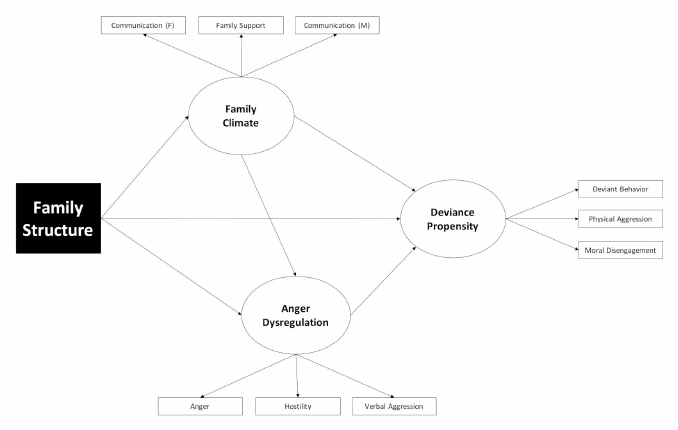
Figure 1. Conceptual